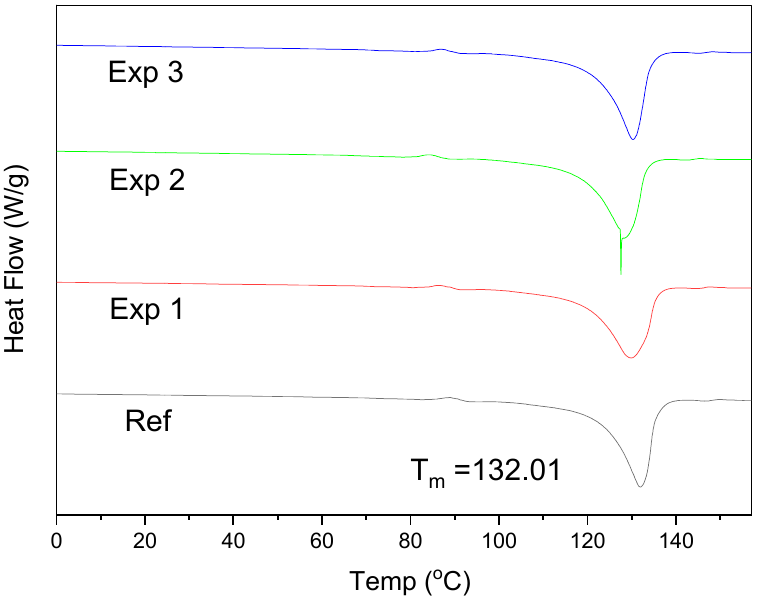
Figure 6. DSC heating curves for virgin and aged samples.